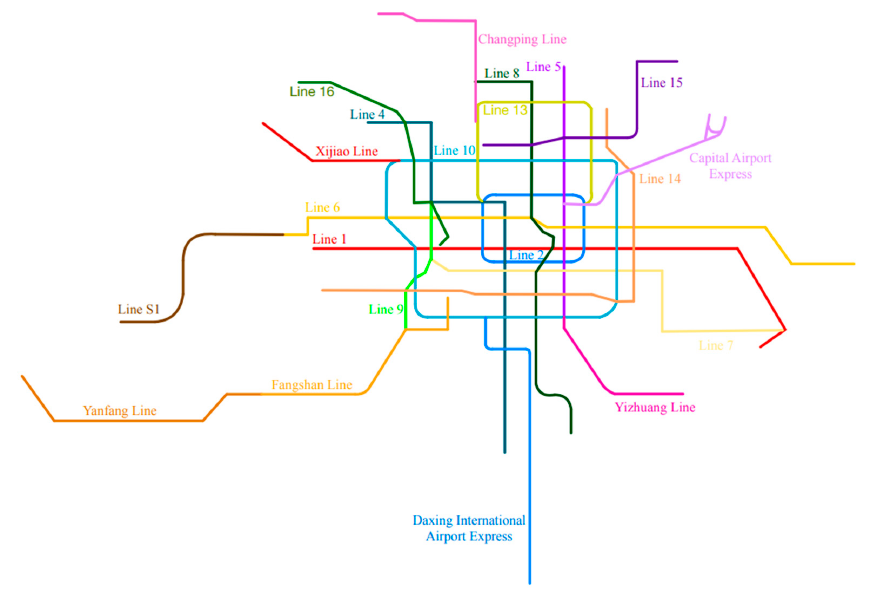
Figure 2. Beijing subway line network.